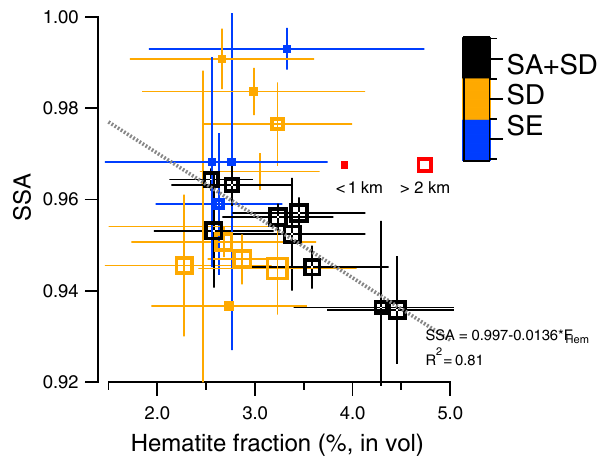
Figure 14. The correlation between SSA and hematite fraction for particles d < 2 . 5µm. The markers show the mean value for each SLR with bars indicating 1 σ variability; the smaller and larger markers denote the measurements in the MBL and SAL, respec-